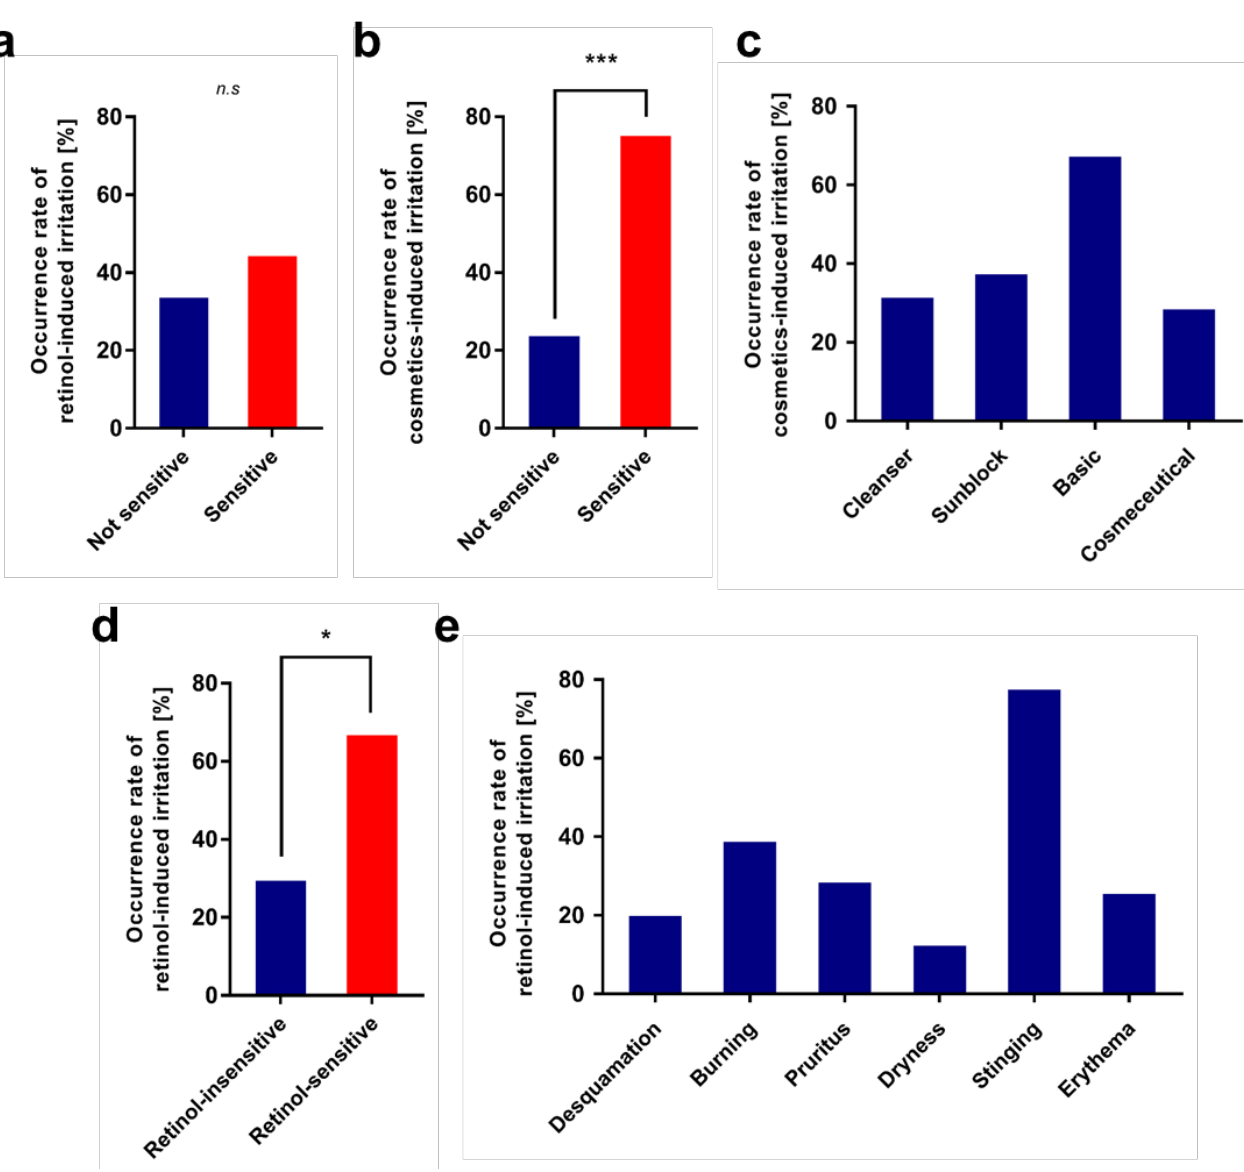
Figure 2. Bar plots depicting the analysis of questionnaires following the test with retinol cream. ( a ) The proportion of individuals who experience irritation to retinol cream according to self-reported skin sensitivity. ( b ) The proportion of individuals who have stopped using cosmetic products due to irritation according to self-reported skin sensitivity. ( c ) The proportion of individuals who experience irritation when using basic cosmetic products. ( d ) The proportion of individuals with a past experience of irritation to retinol-containing products. ( e ) The types of irritation that individuals have experienced during use of retinol-containing topical products; * p -value < 0.05; *** p -value < 0.001; n.s, not